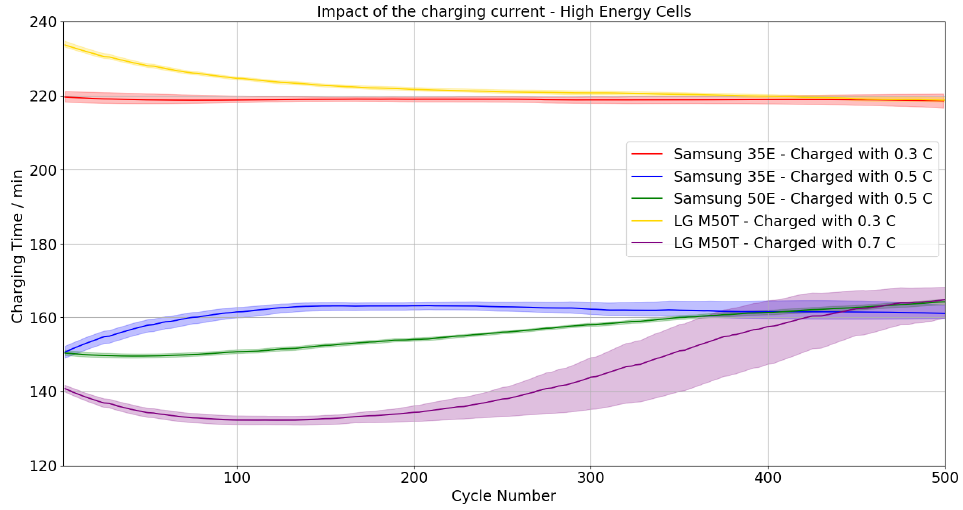
Figure 6. Development of the charging times during the cycle test of the high-energy cells. Solid lines represent the mean values, shaded areas represent the spread of the measured values.